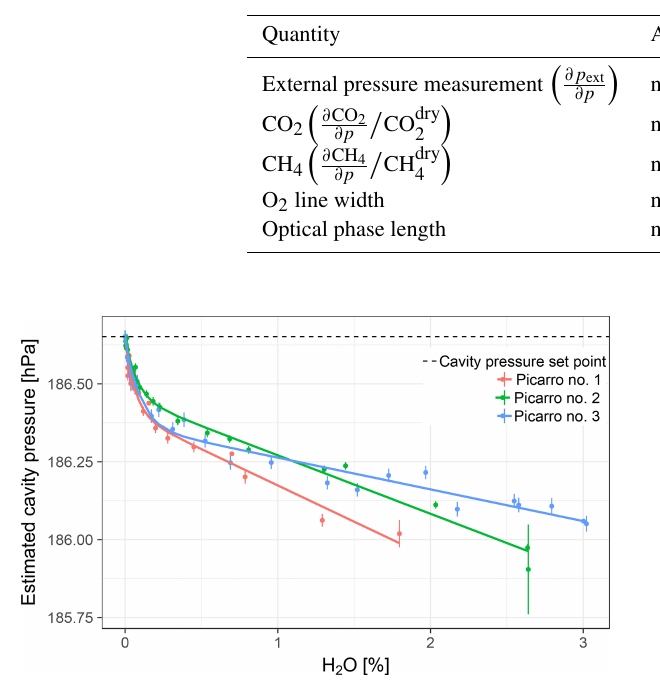
Figure 4. Cavity pressure estimated based on external pressure sen- sor readings in experiments with stable water vapor levels and fits of the empirical cavity pressure model Eq. (4) to the data. Error bars: lower bound of uncertainty; see Sect. S1.2 in the Supplement.